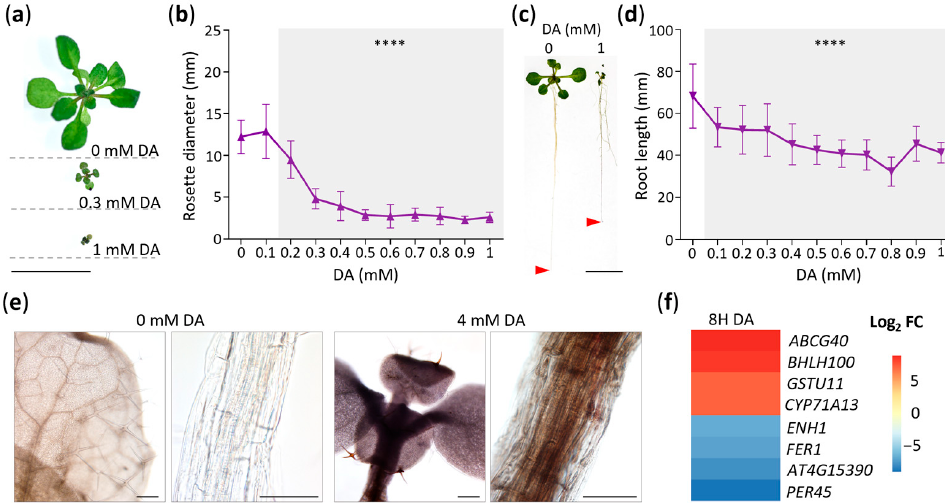
Figure 1. Dopamine (DA) alters plant growth and development. ( a ) Photographs of rosettes of representative 14-day-old seedlings grown on horizontally positioned petri plates with MS/2 media supplemented with the denoted concentrations of DA. Scale bar: 10 mm. ( b ) Rosette diameter of seedlings grown as in ( a ). Seedlings were photographed and rosette diameter was measured using ImageJ software. Data are presented as mean ± SD ( n ≥ 28; **** represents p < 0.0001; one-way ANOVA with Dunnett’s post-test comparing DA treatments to control; shaded area demarks significant results). ( c ) Photographs of 14-day-old seedlings grown on vertically positioned petri plates with MS/2 media supplemented with the denoted concentrations of DA. Representative seedlings were moved to fresh plates for photography. Scale bar: 5 mm. ( d ) Primary root length of seedlings grown as in ( c ). Seedlings were photographed, and root length was measured using ImageJ software. Data are presented as mean ± SD ( n ≥ 20; **** represents p < 0.0001; one-way ANOVA with Dunnett’s post-test comparing DA treatments to control; shaded area demarks significant results). ( e ) Arabidopsis seedlings grown in the presence of DA accumulate melanin in roots and shoots. Col-0 was grown vertically on MS/2 media supplemented with 0 or 4 mM DA for 14 days. Plants were cleared in 100% EtOH and were then rehydrated in 50% glycerol. Scale: 100 µ m. Shoot and root micrographs of each treatment are depicted. ( f ) Top dopamine-responsive genes suggest disrupted iron homeostasis, altered IAA metabolism, and oxidative stress. Gene-level expression data were generated as described in the Materials and Methods, and the top 4 upregulated and downregulated genes at 8 h (8H DA) are presented as a heatmap of log2 fold change (FC). All presented DEGs with a non-zero log2 FC have an FDR <